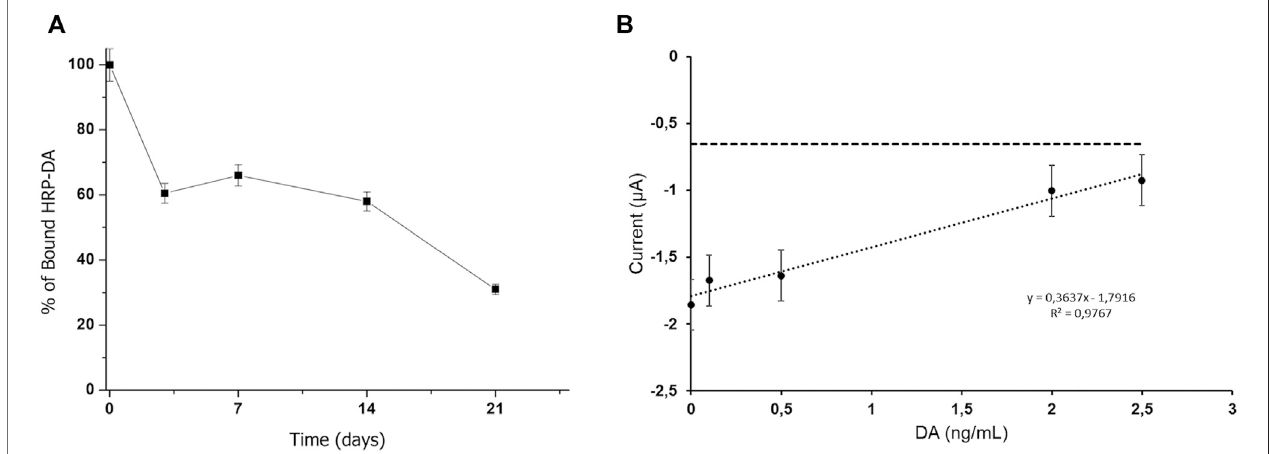
FIGURE 2 | (A) Stability of the Vmh2-ScFv DA – functionalized MBs, (B) electrochemical detection of the competitive assay using Vmh2-ScFv DA – functionalized MBs with the DA concentration in the range from 0 to 2.5 ng/ml. The horizontal line indicates the electrochemical background signal.